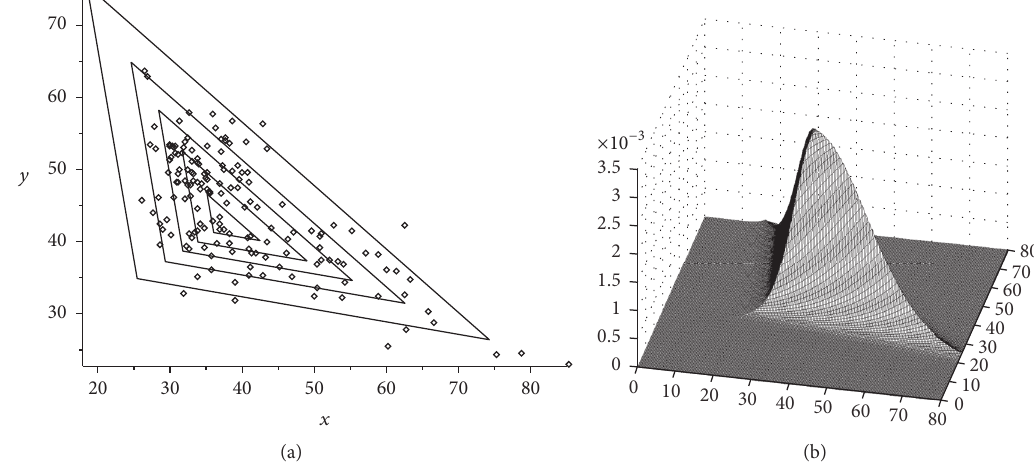
Figure 11: Density levels sets (a) and density (b) of Φ 𝑔, P 𝐿𝑇 ,̂𝑉𝜗+̂𝜌,̂𝑉Ψ̂𝑉 𝑇 .